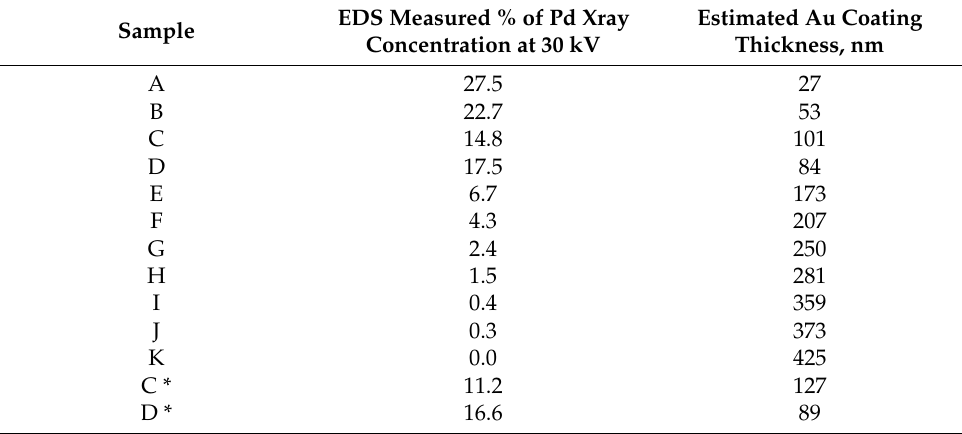
Figure 2. Asymmetric sigmoidal curve fitting of the XRF Au signal intensities of the known thickness of the 7 reference Au strips (red circles) and estimation of Au thickness based on measured % Pd X-ray concentration values at 30 kV for samples A–K (+ C* and D*) (blue triangles). Table 6. Estimated Au coating thickness of samples A–K based on mathematically derived sigmoidal curve fitting constants from % Pd X-ray concentration at 30 kV.